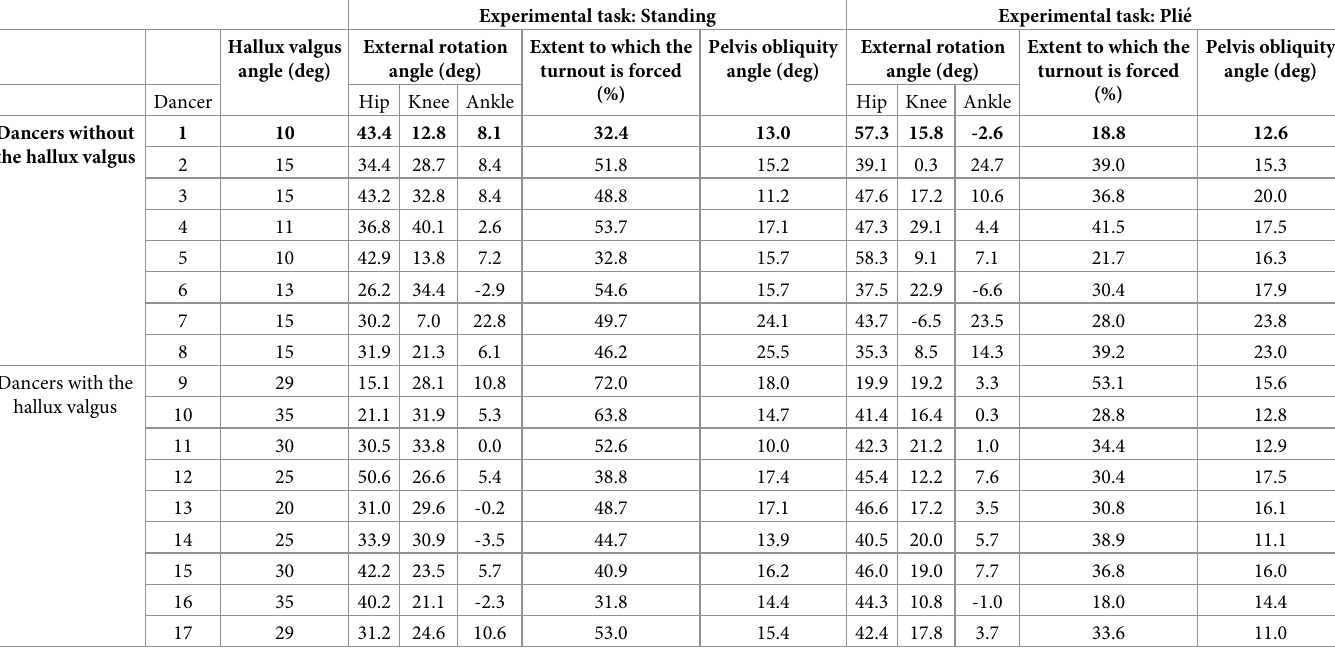
Table 1. Hallux valgus angles and kinematic values for both